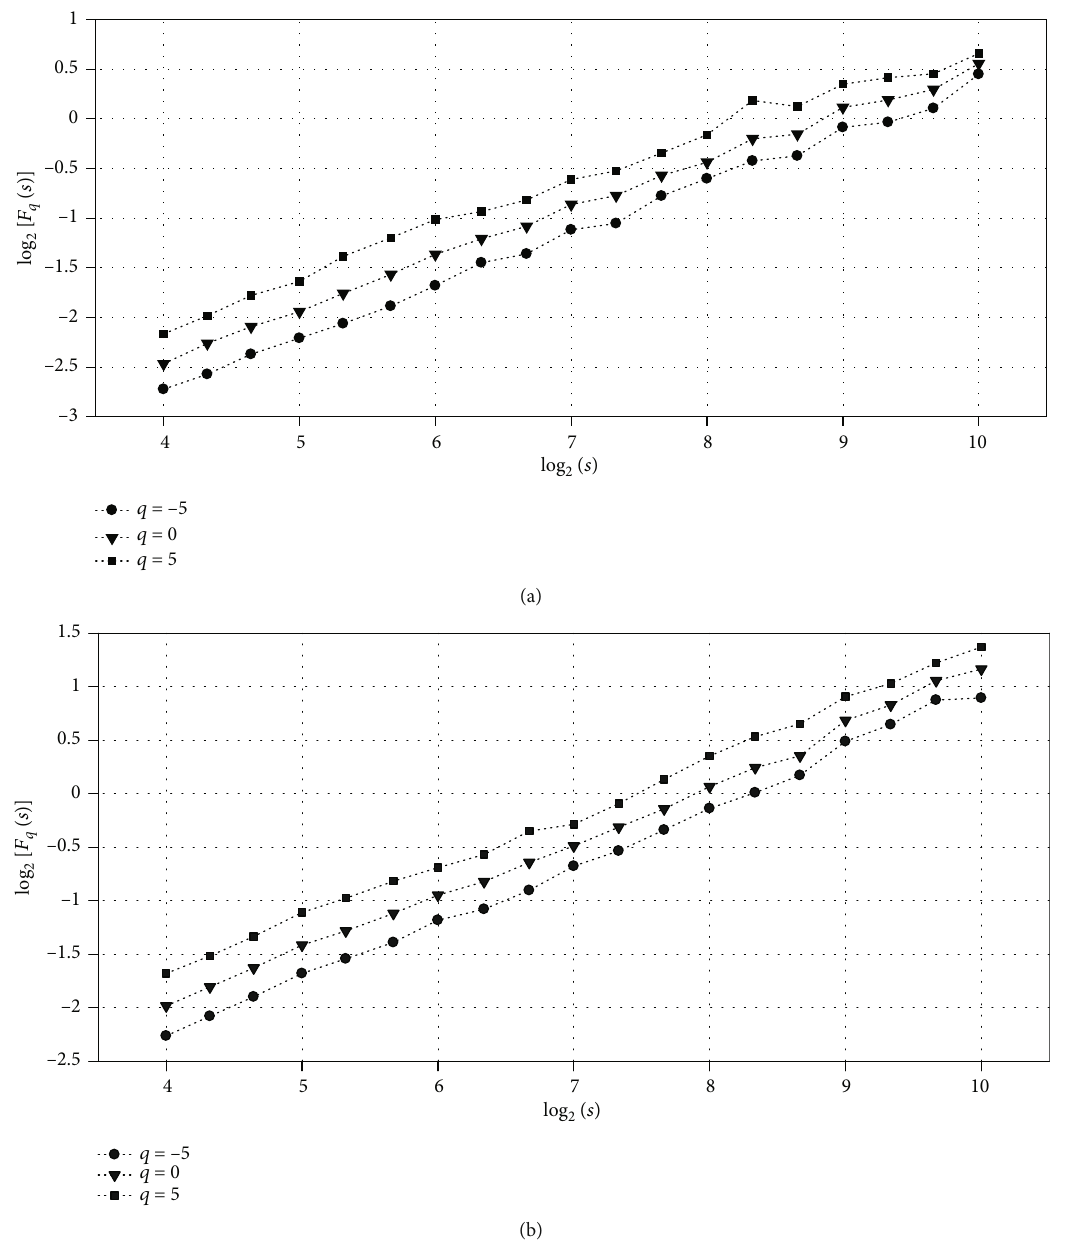
Figure 1: Trend of log ½ Fq ð s Þ(cid:2) vs log ½ s (cid:2) s for q = − 5, 0, 5 , extracted for a particular range of η (a) for 8TeV dataset and (b) for 7TeV 2 2